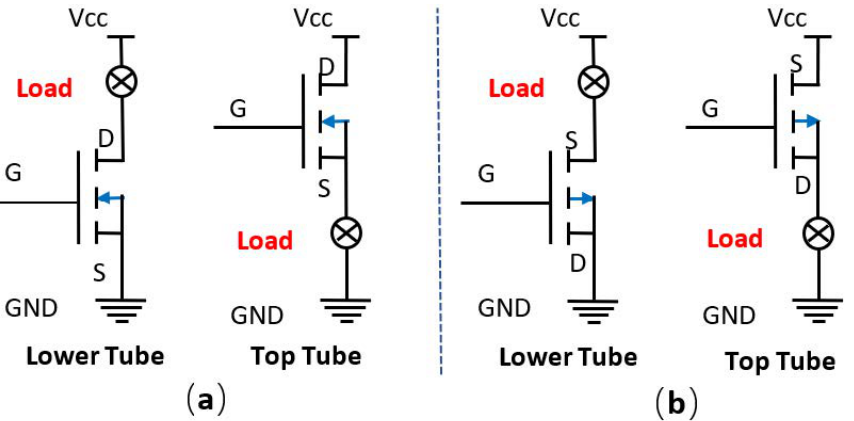
Figure 2. NMOS/PMOS current direction. ( a ) NMOS as upper and lower tubes. ( b ) PMOS as upper and lower tubes.